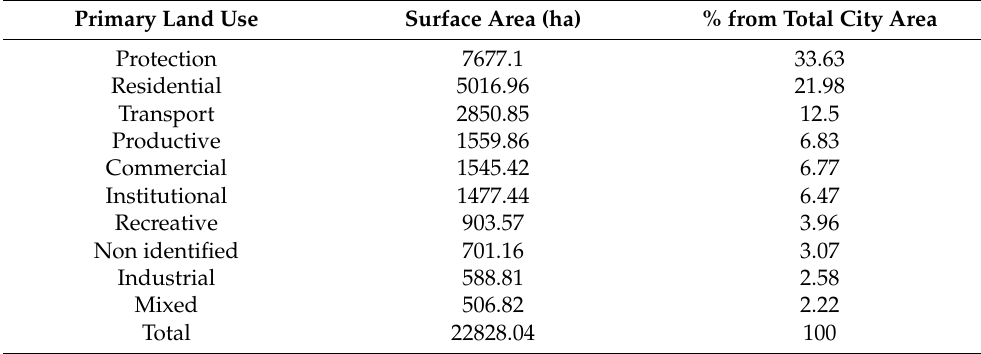
Table 2. Primary Urban Land Uses of Guatemala